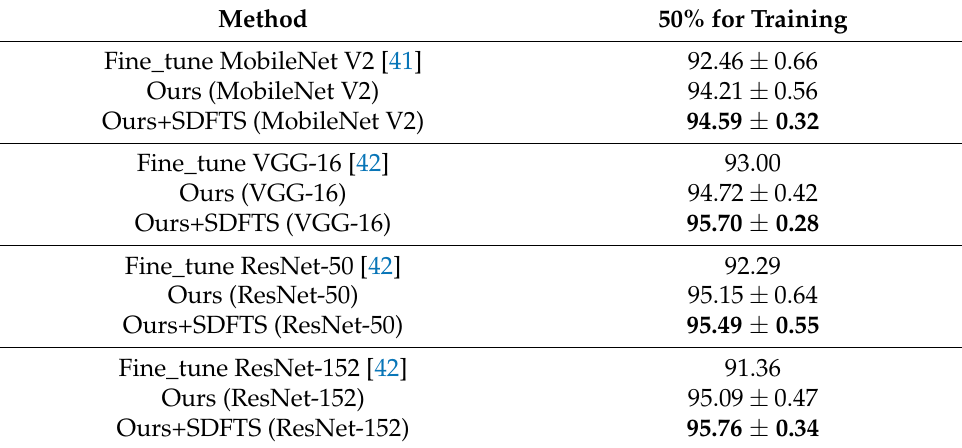
Table 3. The performance comparison on RSSCN 7 dataset with different backbones. SDFTS repre- sents the stochastic decision-level fusion training strategy. The bold values denote the best perfor- mance on different